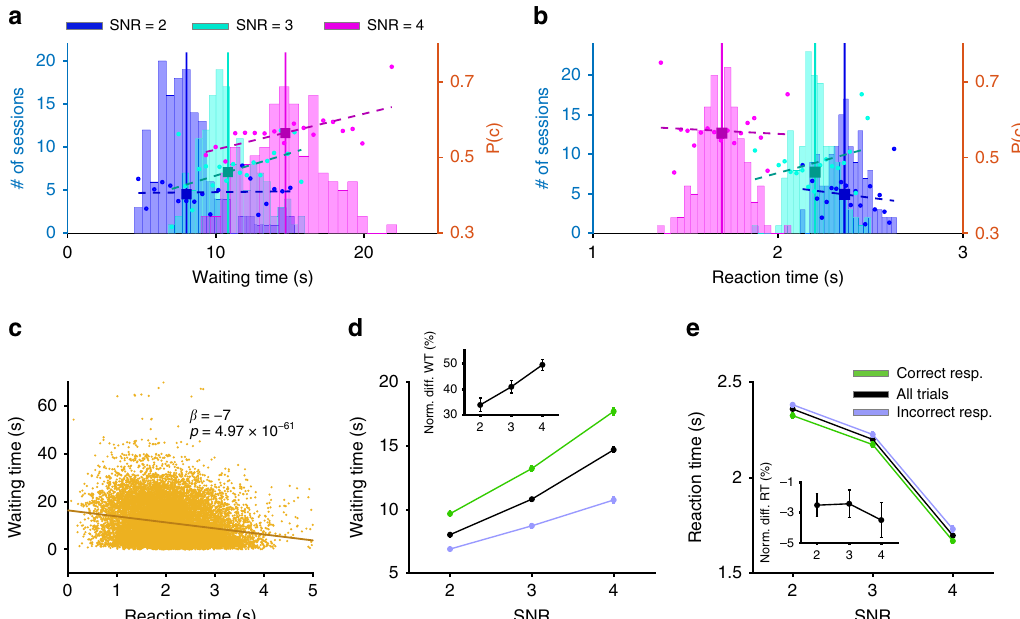
Fig. 2 Waiting time serves as a proxy for con fi dence that is more sensitive than reaction time. a Waiting time before reinitiation increases as SNR increases. Plotted are the distributions of waiting times for each SNR for all sessions, and probability correct ( P ( c )) as a second axis: 2 (blue), 3 (cyan), and 4 (magenta), following vehicle administration. Solid lines show the median of each distribution. b Reaction time decreases as SNR increases. Plotted are the distributions of reaction time for all sessions, and probability correct ( P ( c )) as a second axis. Conventions are the same as in panel a . c Waiting time before reinitiation of a new trial is negatively correlated with reaction time to make a choice. Waiting time is plotted as a function of the reaction time for all trials and all rats. Each data point is a trial in a session following vehicle administration. d Waiting time is larger for correct compared to incorrect responses for any SNR. Plotted is waiting time for all trials (black), correct trials (green), and incorrect trials (purple) for different SNR. The inset shows the relative difference in waiting time between correct and incorrect responses for different SNR. Error bars show the S.E.M. over sessions (typically smaller than the symbol). e Reaction time only weakly re fl ects the accuracy of the response. Plotted is the reaction time for all trials and separately for correct and incorrect responses. Conventions are the same as in panel d . The inset shows the relative difference in reaction time between correct and incorrect responses for different SNR. Overall, response accuracy is re fl ected in waiting time an order of magnitude better than in reaction time. Source data are provided as